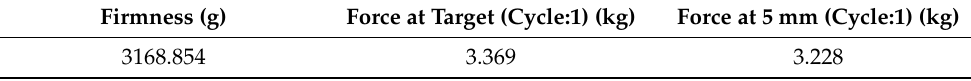
Table 9. Test data of